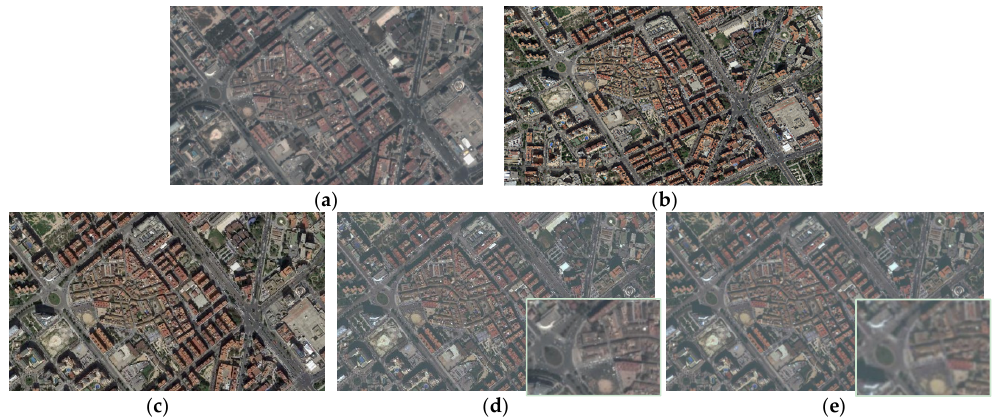
Figure 8. Reference images. ( a ) Sample frame from satellite video clips building-1; ( b ) cropped image from a large image downloaded from © Google Earth; ( c ) reference image I g r after geometric matching; ( d ) reference image I c r from I g r after radiometric adjustment; ( e ) final background reference image I r from I c r after quality adjustment.